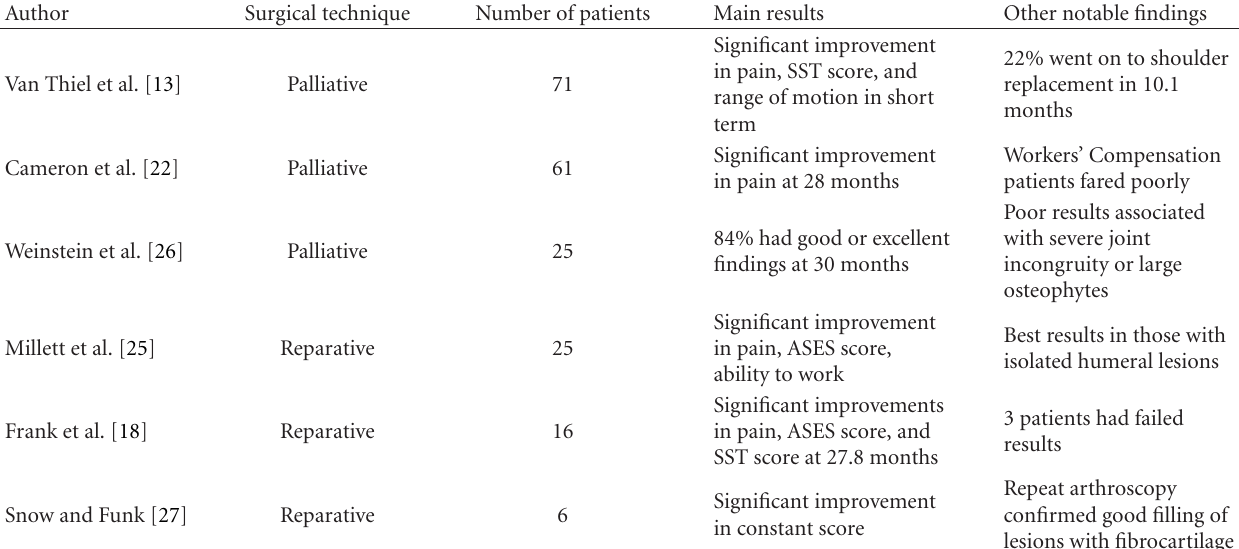
Table 1: Outcomes of palliative and reparative treatment for glenohumeral